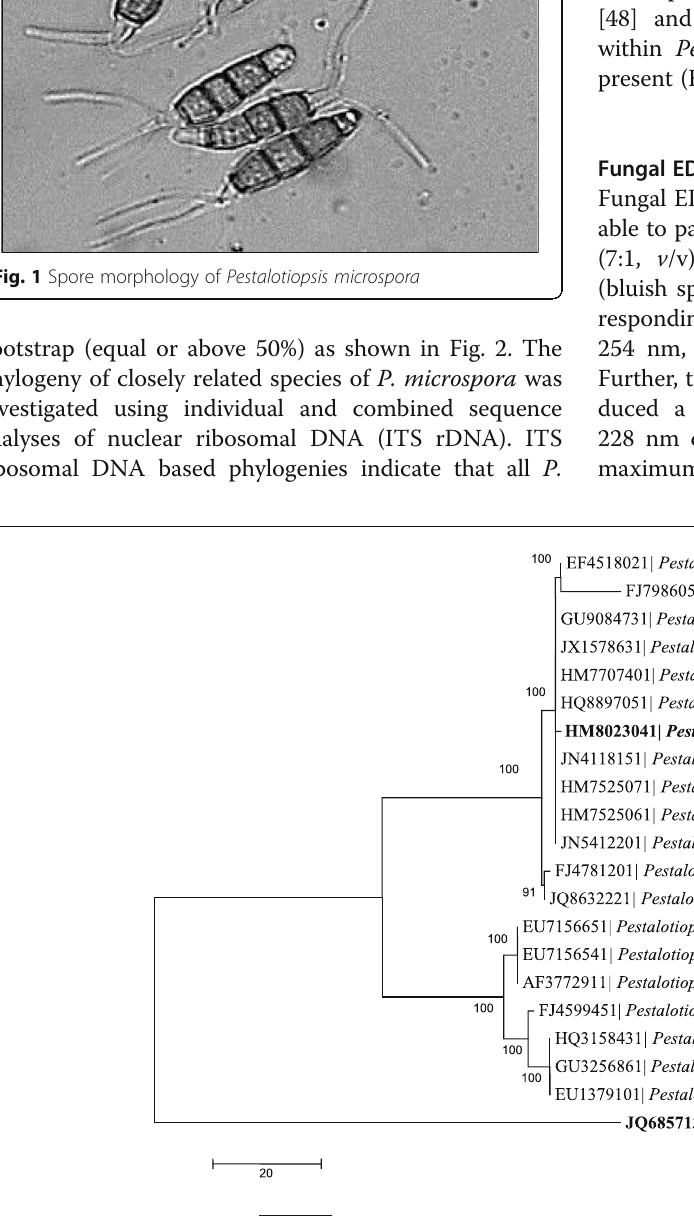
Fig. 2 Maximum parsimony phylogram showing phylogenetic relationships among isolates of Pestalotiopsis microspora data were analysed with random addition sequence. Values in the branches are parsimony bootstrap equal or above